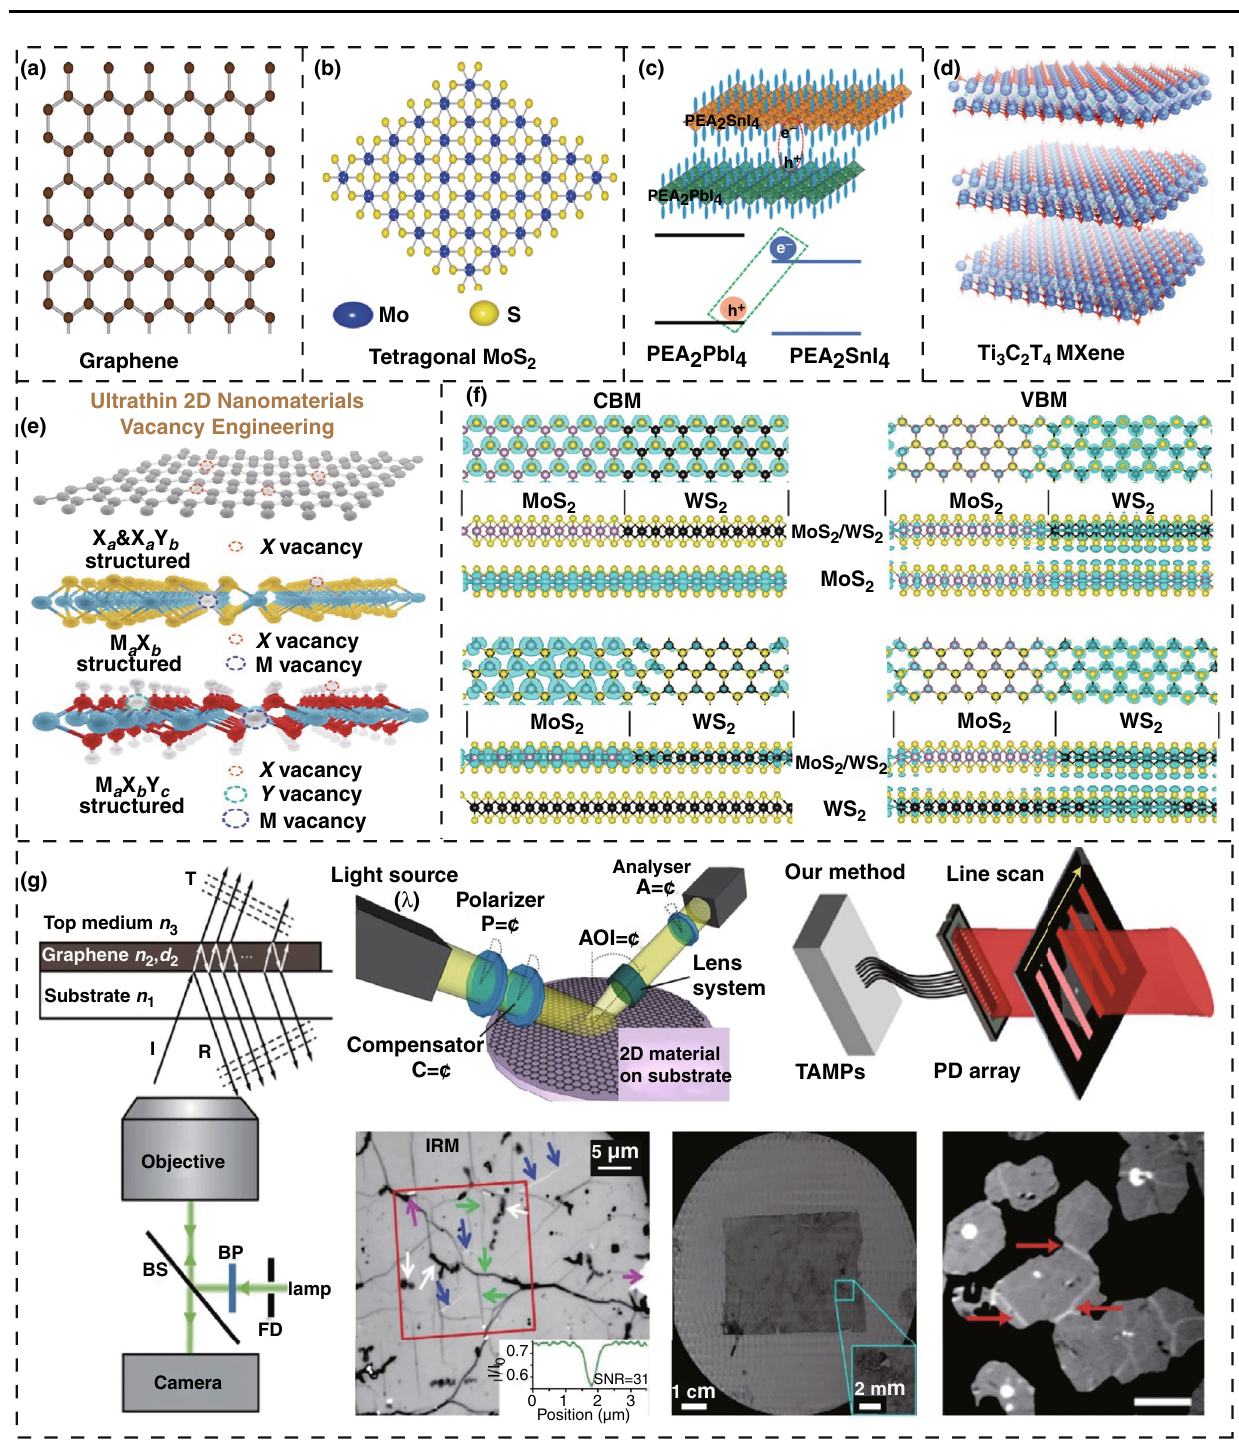
Fig. 1 Introduction of some nanomaterials and some modifications. a A single-layer graphene sheet. b Transition metal dichalcogenide. c Het- erostructure of 2D perovskite. d Ti 3 C 2 T x MXene. e Diagram of 2D nanomaterial structure and type of vacancy(s). f CBM and VBM’s charge density in lateral heterostructure of MoS 2 /WS 2 . g Characterization techniques to detect abnormalities using optical methods. Figures reprinted with permission from: a Ref. [23], © 2014 American Institute of Physics; b Ref. [30] © 2016 Elsevier; c Ref. [37], © 2020 Nature; d Ref. [38], © 2019 Wiley; e Ref. [54], © 2020 Wiley; f Ref. [56], © 2015 American Chemical Society; g Ref. [28], © 2019